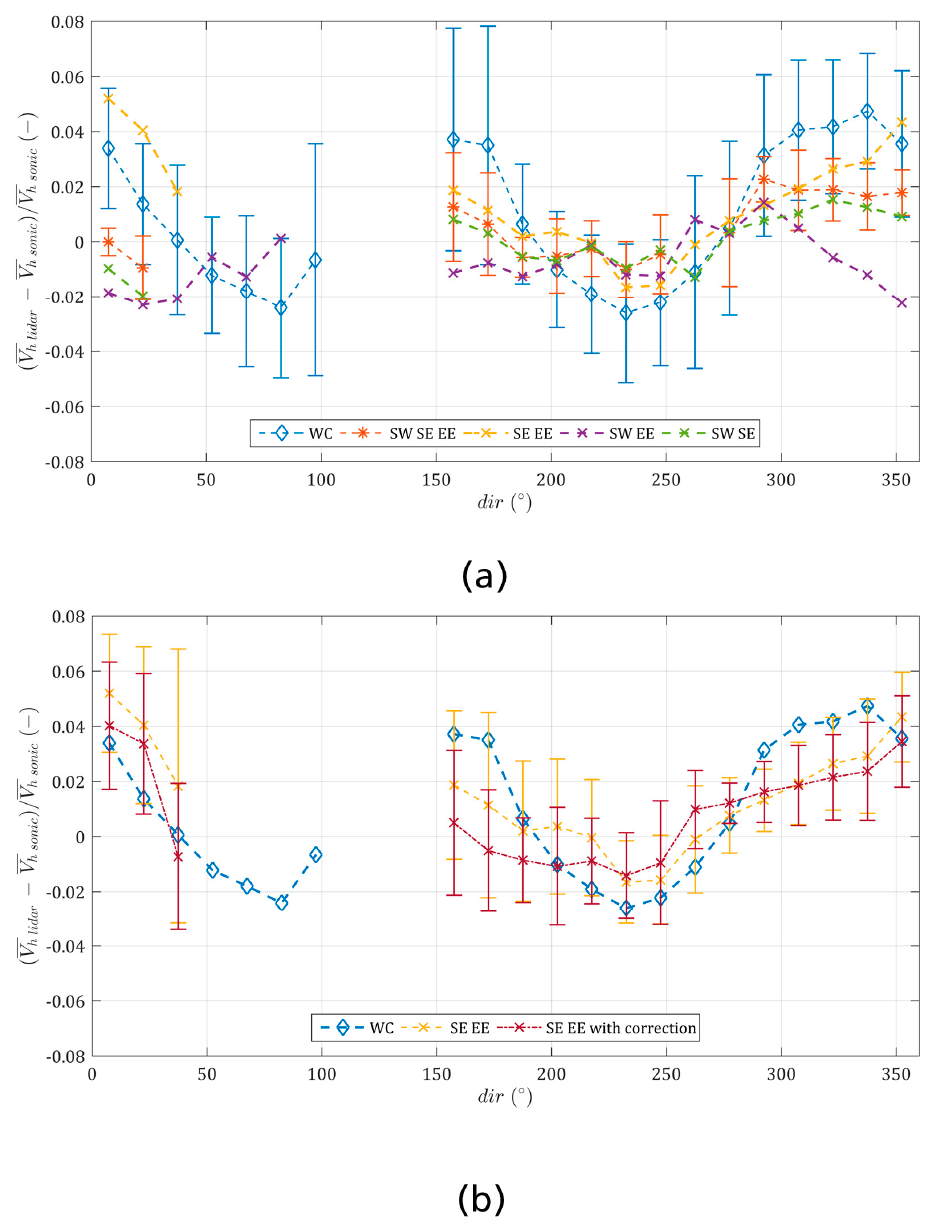
Figure 6. ( a ) mean of the directional deviation in V h between the sonic and the different lidar configurations; ( b ) same as ( a ) but for the SE/EE combination with and without the correction for w ; see text for details; periods during which V h sonic < 4 m · s − 1 were excluded from the comparison to increase the comparability to other complex terrain measurements reported in the literature. Also, bins with n < 5 are not displayed; error bars denote ± one standard deviation.